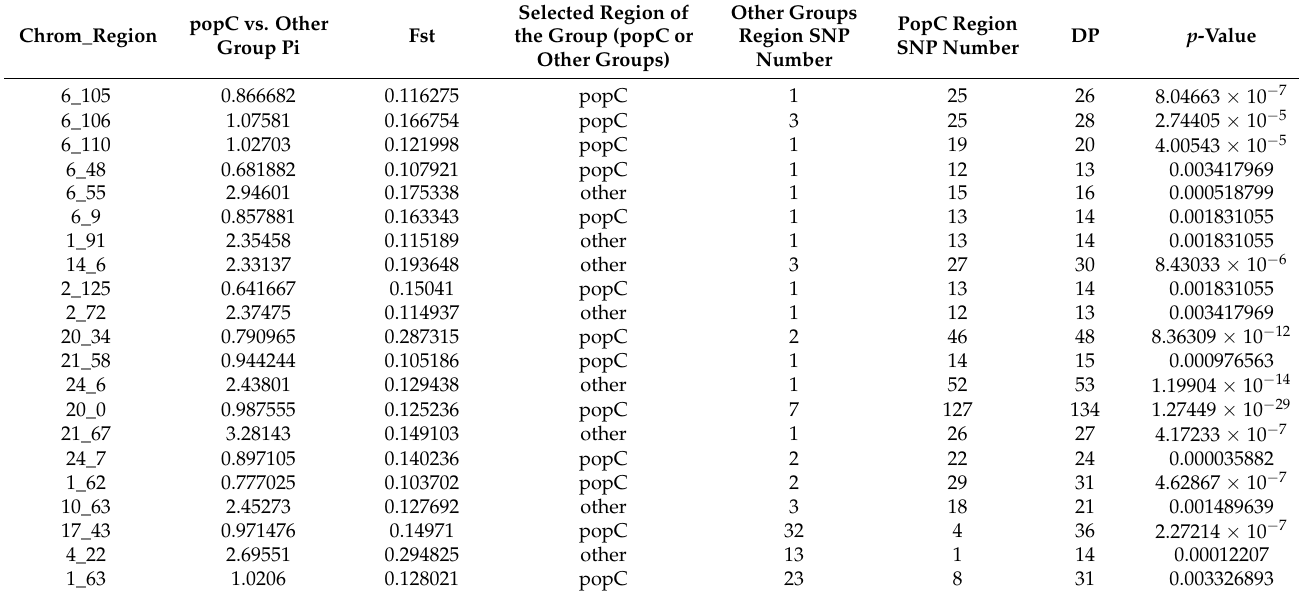
Table A3. Twenty-one population-specific SNP regions of the chromosome in popC compared with other